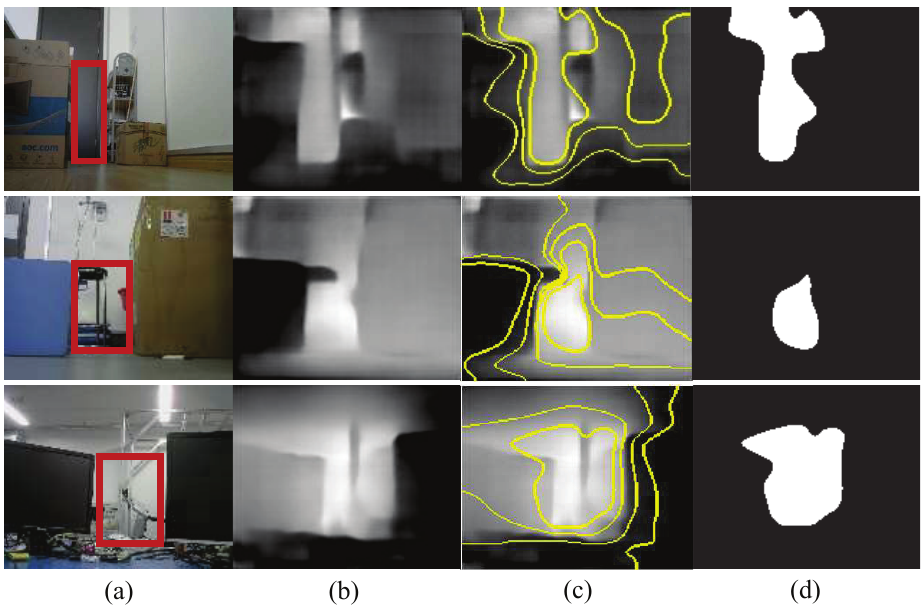
Figure 16. Superpixel dynamic path planning algorithm processing effect and sample comparison effect: ( a ) original scene map, ( b ) depth map, ( c ) superpixel segmentation result, and ( d ) average maximum superpixel block.